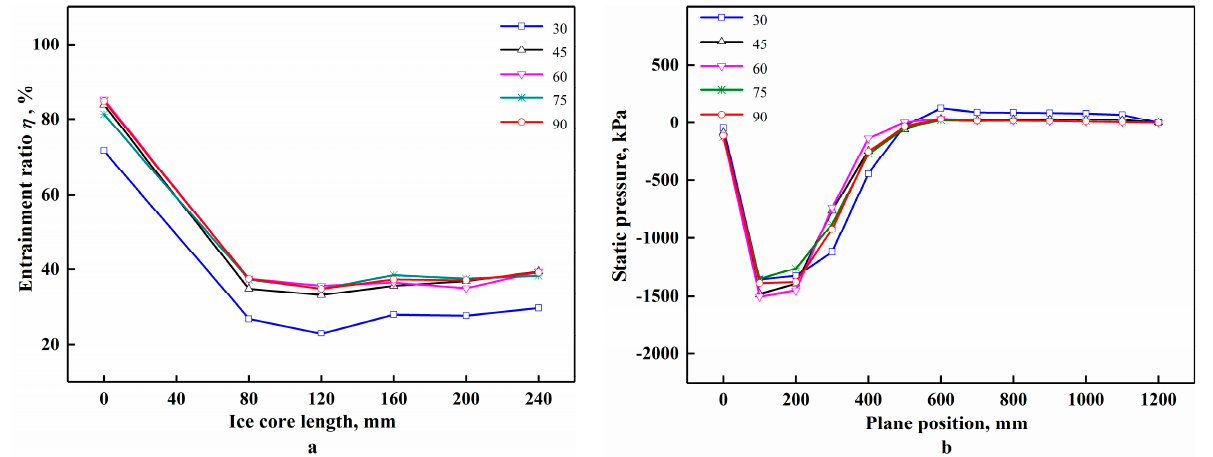
Figure 7. Results of different helical angles for drill bits with flushing nozzles opened: ( a ) influence of helical angles on entrainment ratio; ( b ) pressure distribution of central passage.